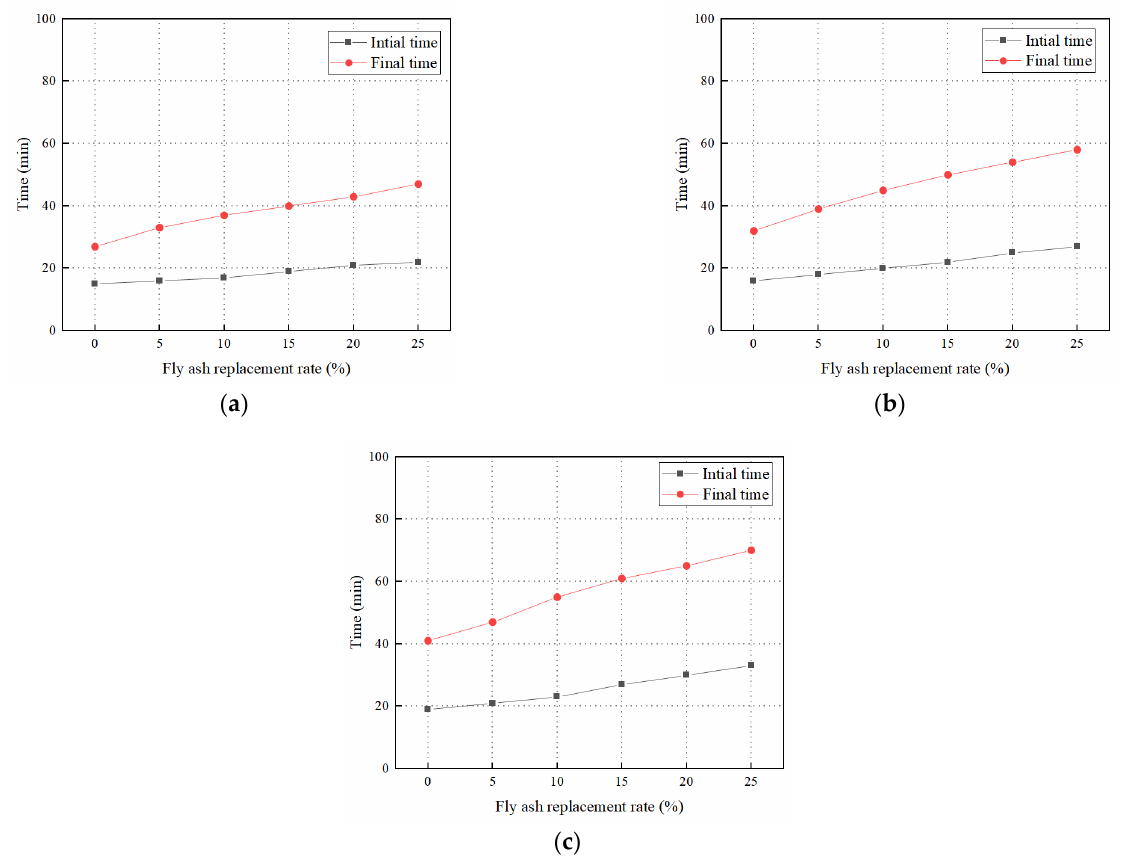
Figure 5. Setting time of composite cementitious materials with different DFA substitution rates ( a ) water to binder ratio 0.3 ( b ) water to binder ratio 0.4 ( c ) water to binder ratio 0.5.